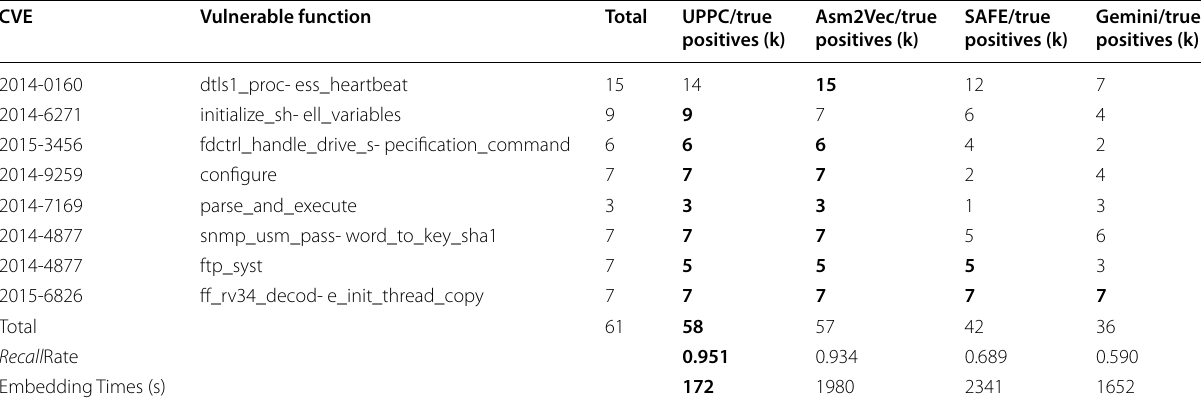
Table 5 Real-world vulnerability analysis results